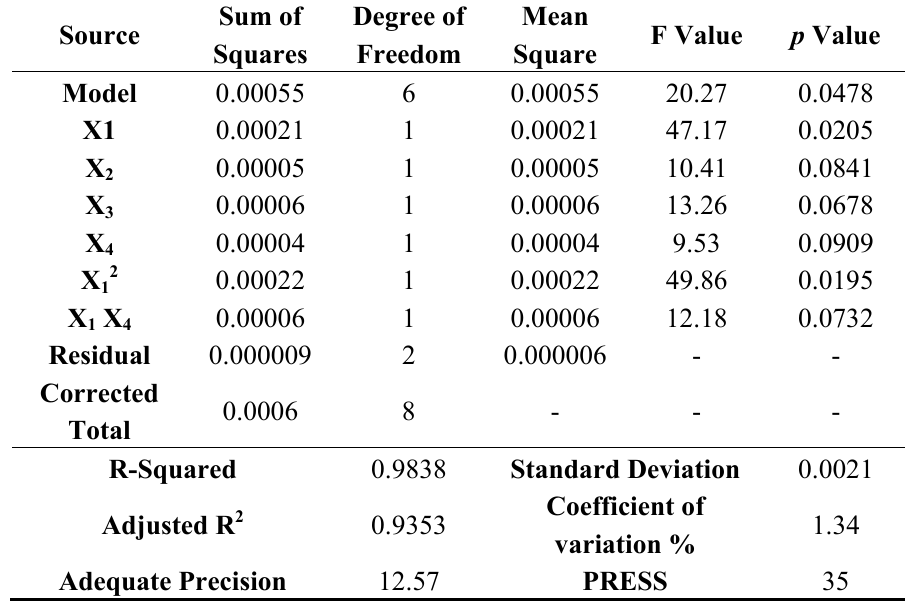
Table 4. Analysis of variance for surface roughness of SnO